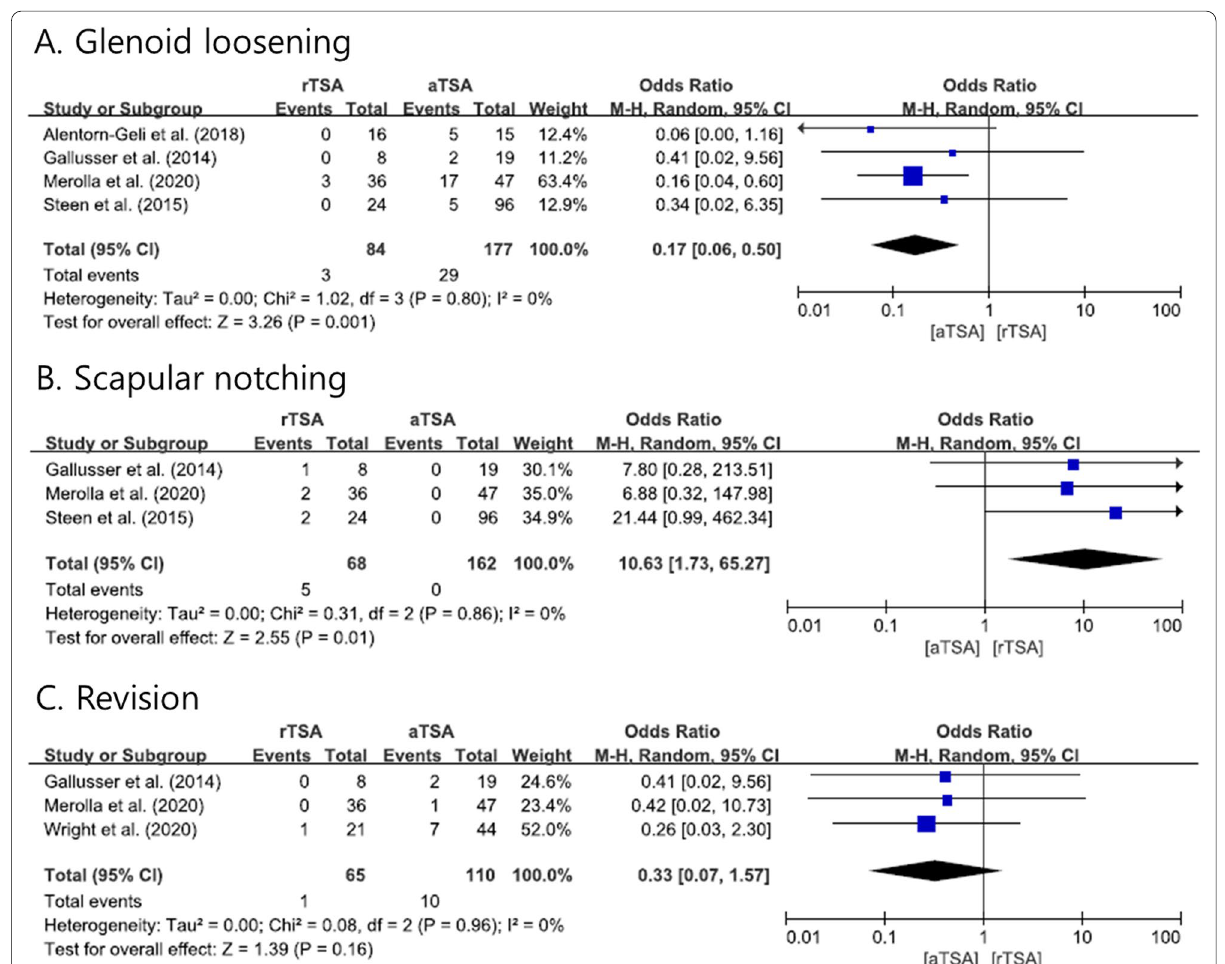
Fig. 4 Forest plots showing the odds ratios of complications due to reverse total shoulder arthroplasty and anatomical total shoulder